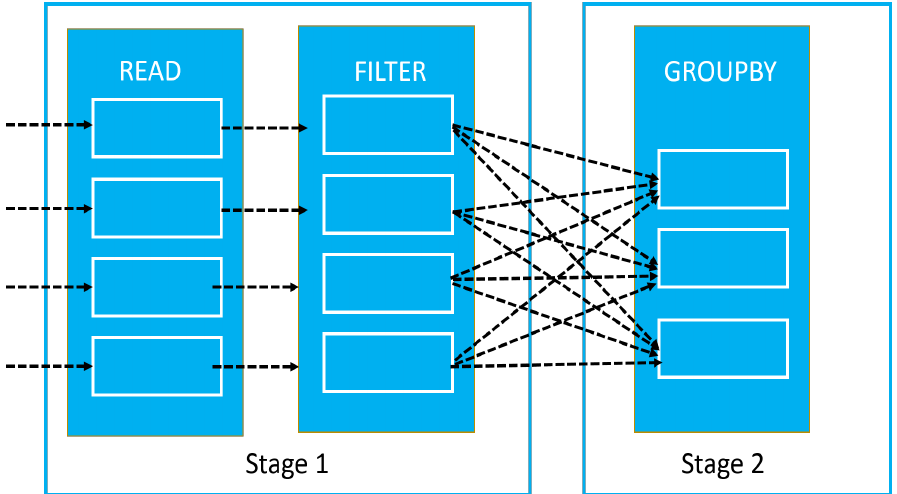
Figure 7. Example of a Spark